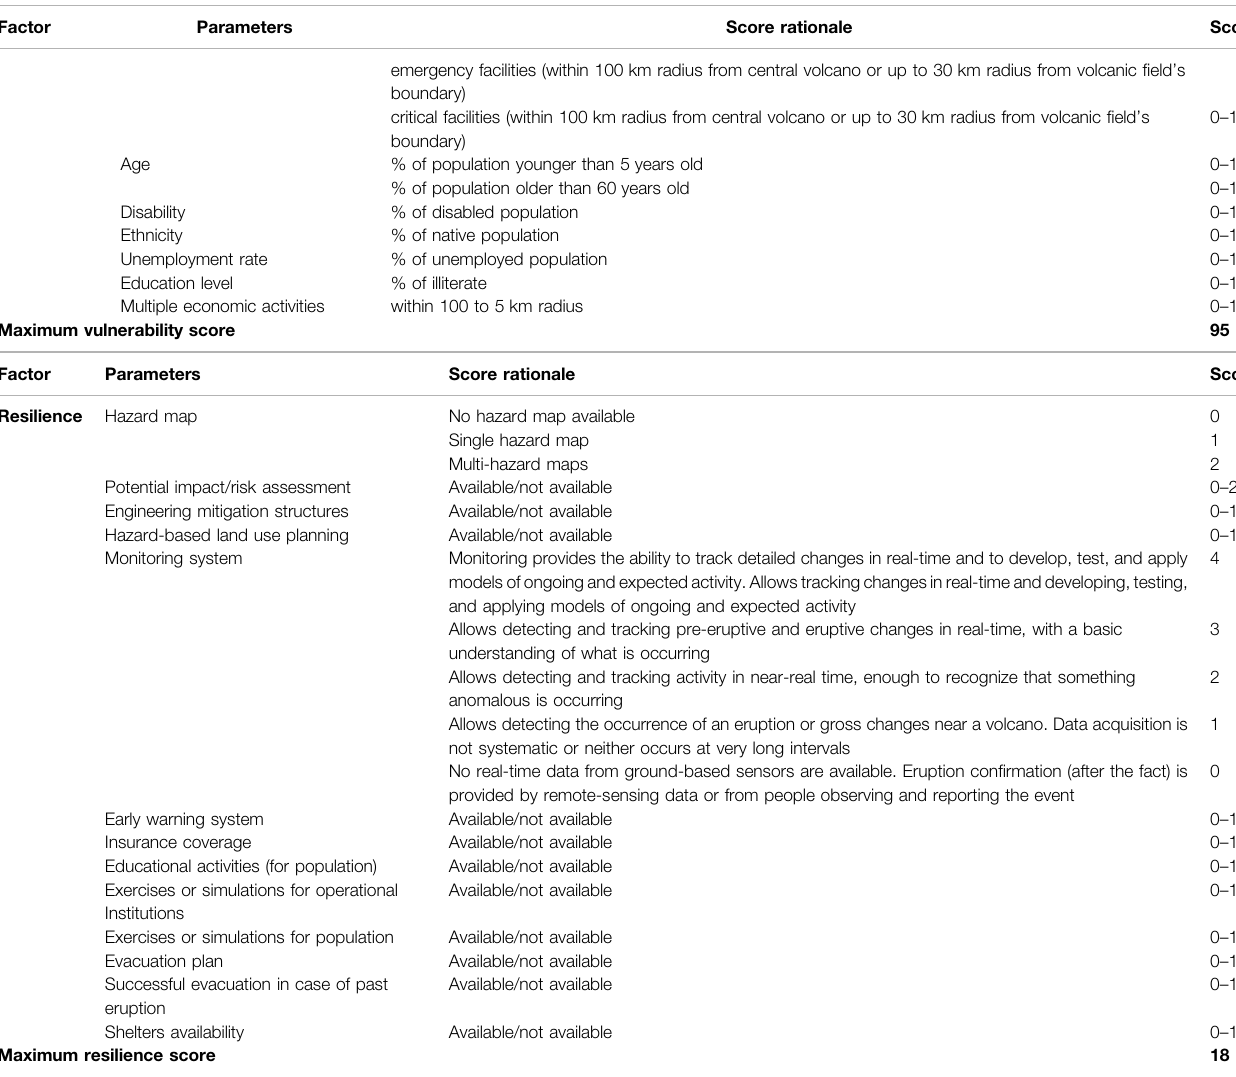
TABLE 1 | ( Continued ) List of parameters and elements analyzed for each factor (hazard, exposure, vulnerability and resilience) and their respective score